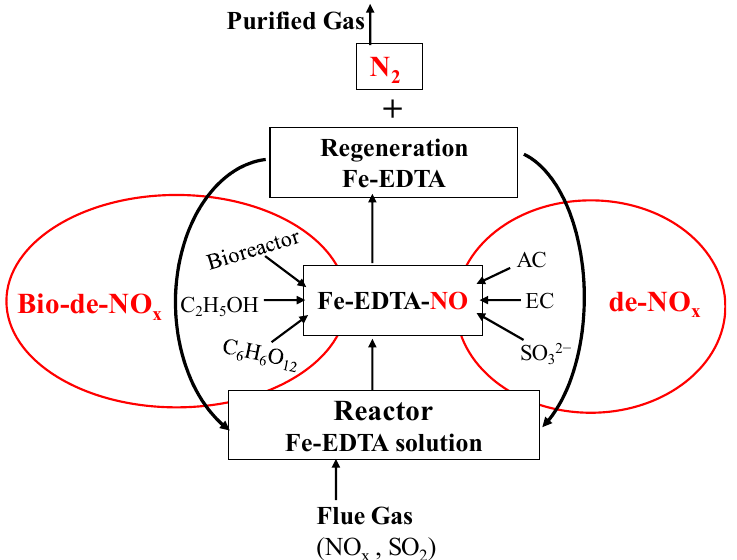
Figure 4. Schematic diagram for de-NO x and bio-de-NO x . The absorption of NO x for Fe-EDTA-based wet scrubbing is the same but reduction after making metal-nitrosyl-complex is different. The reduction in de-NO x /chem-de-NO